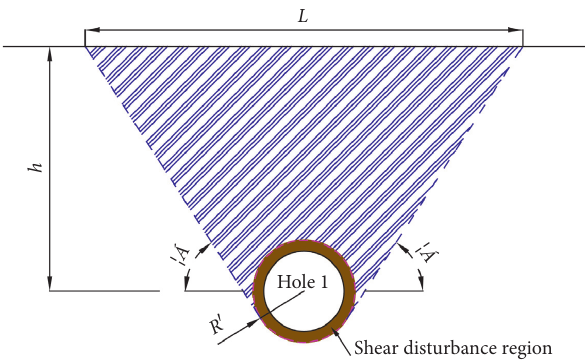
Figure 2: Schematic diagram of lateral disturbance range of single-hole